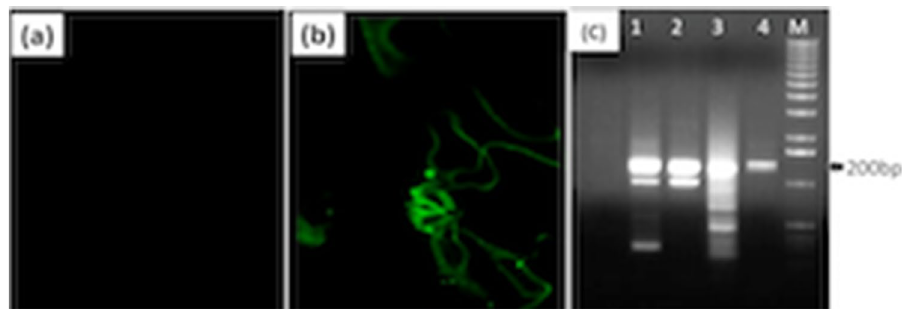
Figure 4. The confirmation of GFP gene transformation via Laser Scanning Confocal Microscope and PCR ( a , b ). The green fluorescence in transgenic Okra plants confirmed the gene delivery and its successful expression of GFP gene. ( c ) The PCR amplicons also corresponded to 200 bp as compare to the DNA ladder that confirms the delivery of GFP gene.